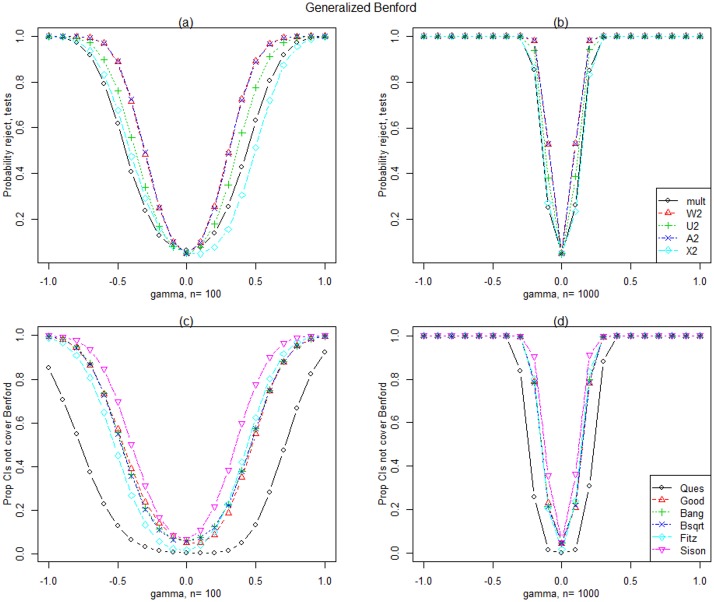
Generalized Benford distribution results.Simulated power for the tests and simultaneous confidence intervals when data is generated from the Generalized Benford distribution with various values of γ and for two sample sizes.